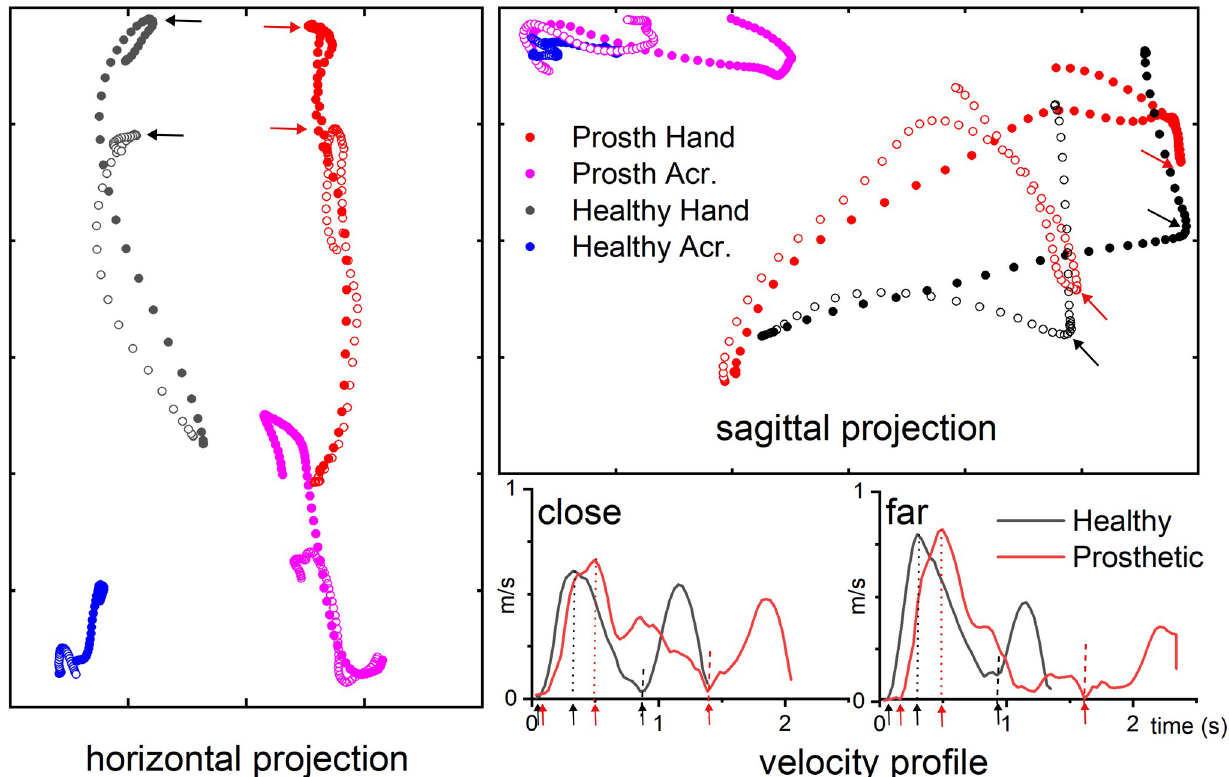
Fig 3. Example of hand and acromion trajectories in a representative participant. Horizontal (left) and sagittal (right) projections of the hand (black circles) and prosthesis (red circles) superimposed trajectories for the far (filled circles) and the close (open circles) targets, the object is a cylinder. The trajectories of the acromion sensor on the non-amputated (blue circles) and prosthetic (magenta circles) sides are also indicated. The corresponding velocity profiles are displayed on the right bottom corner for the close and the far targets. On the velocity profiles, black and red arrows indicate the times tr (onset of movements), tv (time of maximum velocity) and tg (time of grasping); the times tv and tg are also indicated by dotted and dashed lines respectively. The times tg are also indicated by arrows on the hand trajectories.